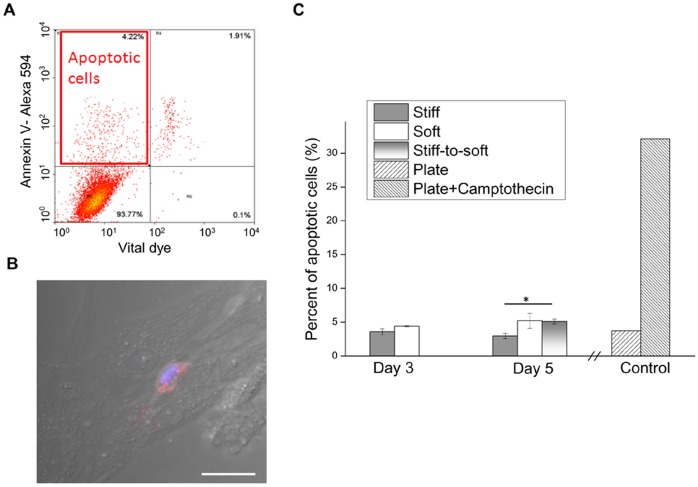
Decreased number of myofibroblasts on stiff-to-soft gels was not due to apoptosis.VICs cultured on different PD-PEG gels were stained with Annexin V linked with Alexa Fluor 594 and DAPI to detect apoptosis. (A) Scatter plot of Annexin V and DAPI staining for VICs cultured on stiff gels. Red box: apoptotic cells with high fluorescence in the Annexin V channel and low fluorescence in the DAPI channel. (B) A representative confocal image of a cell stained positively for Annexin V (red) overlaid with transmitted light DIC on stiff gels. Positively-stained cells were observed to exhibit a rounded morphology. Blue: Nucleus. Scale bar: 20 µm. (C) Quantification of apoptosis based on flow cytometry as shown in (A). Low levels of apoptosis were detected for VICs cultured on either gels or plastic plates. VICs treated with camptothecin, an apoptosis-inducing reagent, showed a much higher level of apoptosis than any gel-based culture condition or plastic plate. * indicates p<0.05.